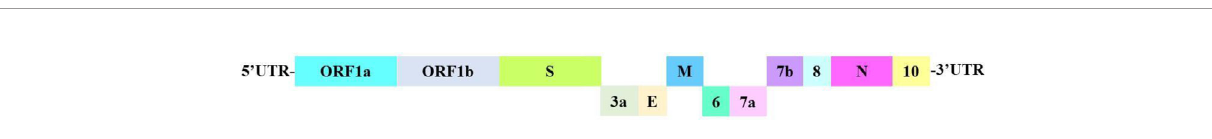
FIGURE 2 | Schematic representation of SARS-CoV-2 genomic sequence. UTR, Untranslated region; ORF, Open reading frame; S, Spike protein; E, Envelope protein; M, Membrane protein; N, Nucleocapsid